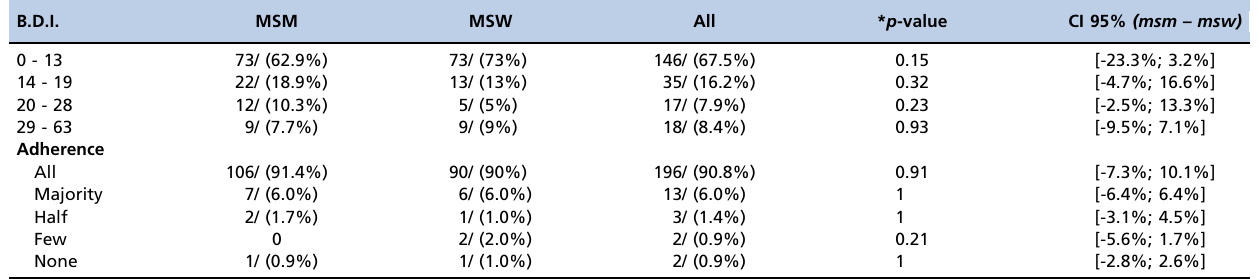
Table 2 - Absolute numbers and respective percent of depression by Beck depression inventory (BDI) and adherence data by START questionnaire.